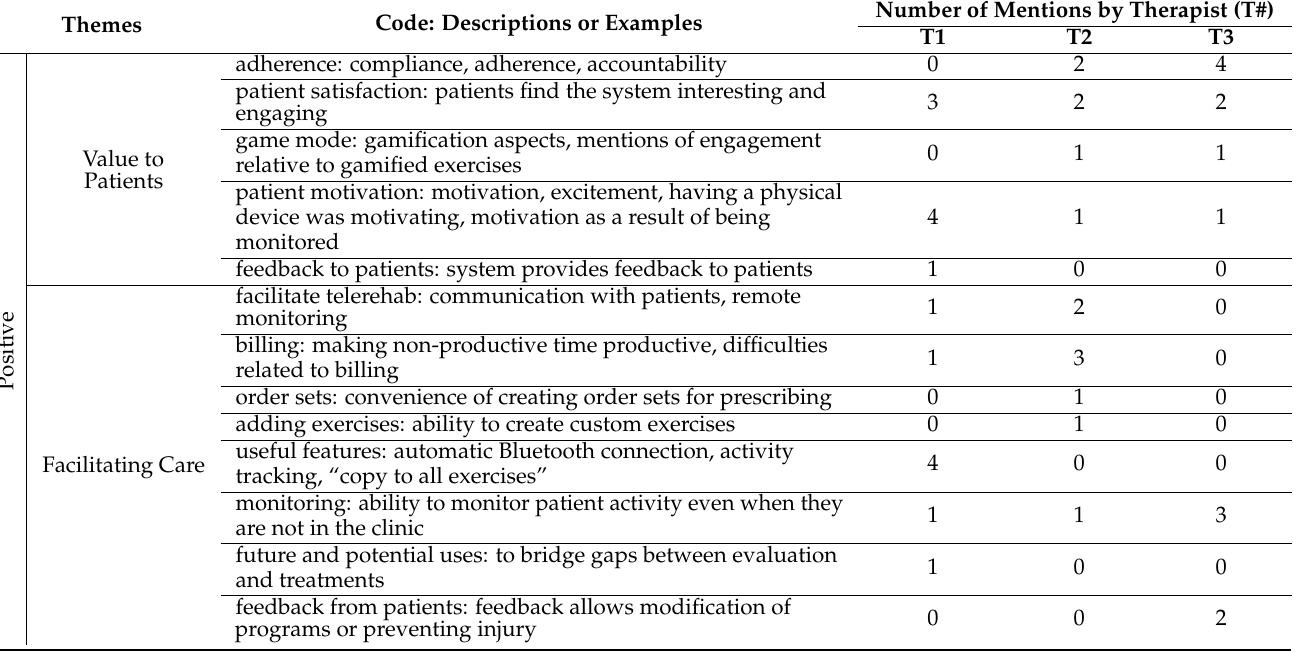
Table 7. Summary of content analysis results from end of study interviews with outpatient